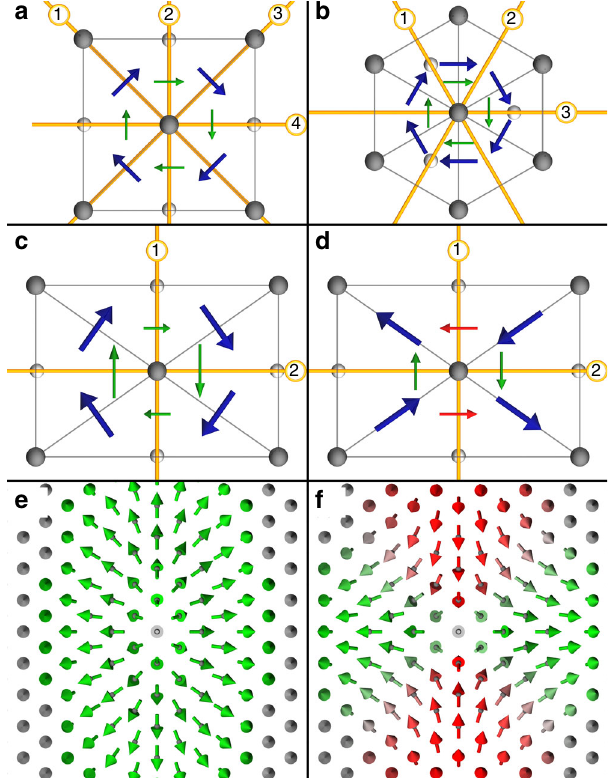
a , b Sketch of a square (hexagonal) lattice with C 4 v ( C 3 v ) symmetry. Mirror planes (numbered from 1 to n) are indicated by orange lines , atoms in the surface (second) layer by gray ( white ) balls . The microscopic DM vectors ( blue arrows ) between n.n. sites projected onto the crystal surface are in both cases restricted by symmetry to point perpendicular to the